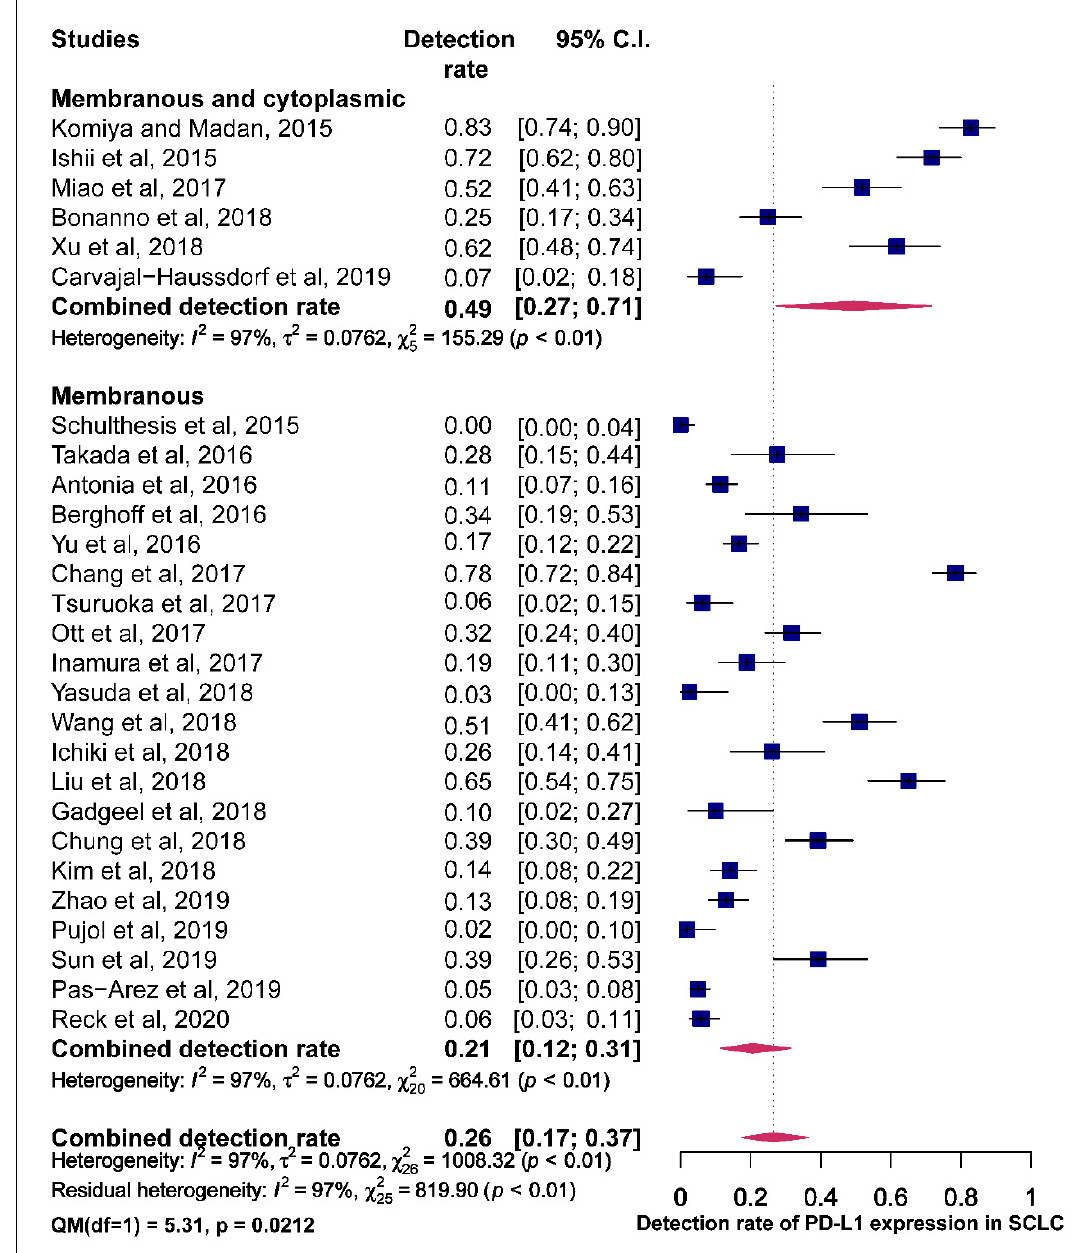
Figure 5. Forest plot of subgroup analysis of the association between the assessment of PD-L1 staining pattern in membrane+/-cytoplasm and prevalence of PD-L1 expression. The PD-L1 detection rates and 95% CI of each study are represented with a horizontal line and the square area mirrors the size effect of each study.